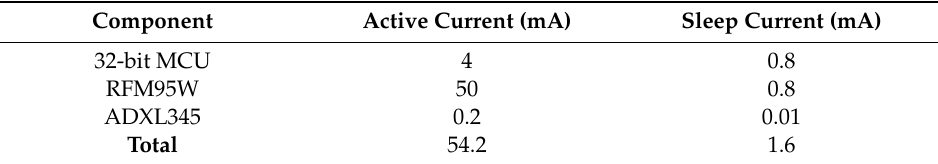
Table 3. Current consumption in fall detection system.